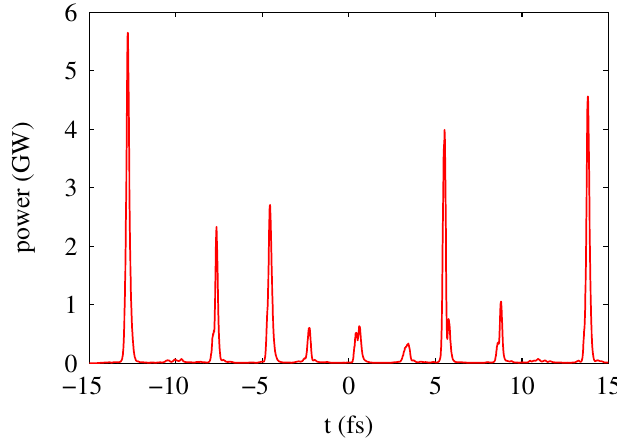
FIG. 5. (Color) A typical example of the radiation profile at an undulator distance of 50 m without any undulator tapering. The large energy spread induced from LSC in the bunch center degrades the FEL